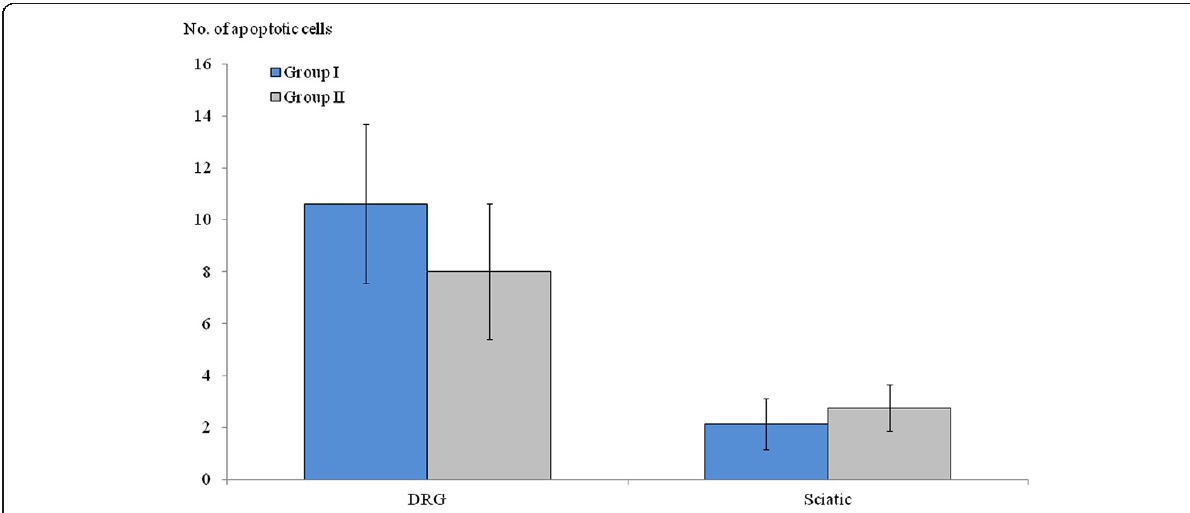
Figure 4 The comparison of apoptotic-featured cells between the two groups. The statistical significances of the number of apoptotic cells were not found in dorsal root ganglia or sciatic nerve between two groups, which were harvested at 6 weeks after oxaliplatin administration ( P>